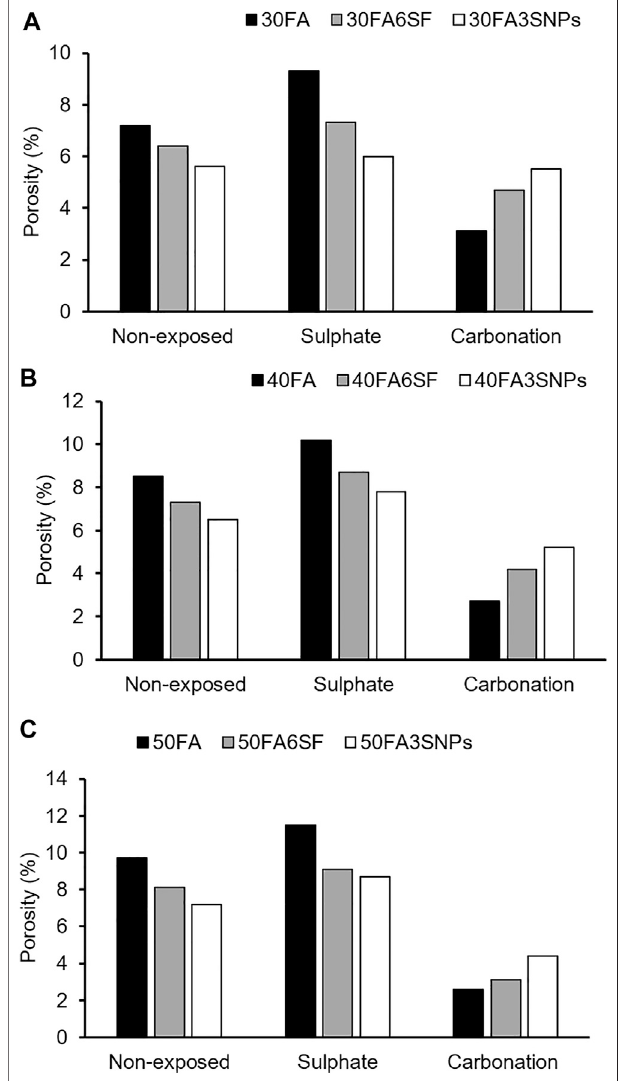
FIGURE 6 | The porosity of exposed and non-exposed (A) 30% fl y ash containing3%SNPs and6%SF (B) 40% fl yashcontaining3%SNPsand 6% SF and (C) 50% fl y ash containing 3% SNPs and 6% SF incorporated concrete samples after 365 days of